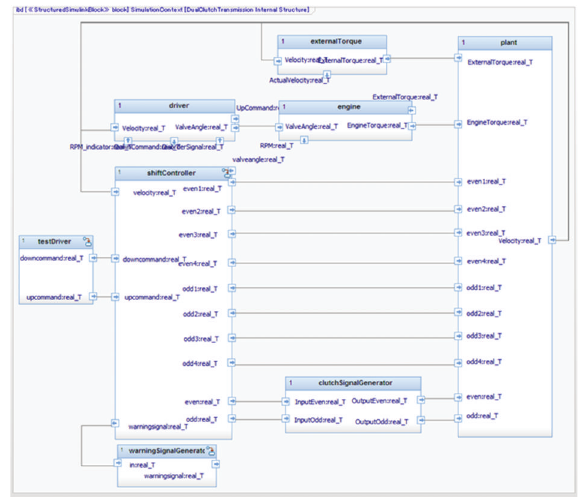
Figure 16: Internal structure of the simulation context.